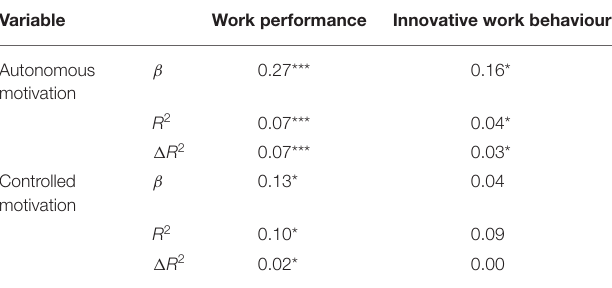
Table 3 , the hierarchical moderated regression analysis table for only AM × FS on WP as well as AM × FS on IWB